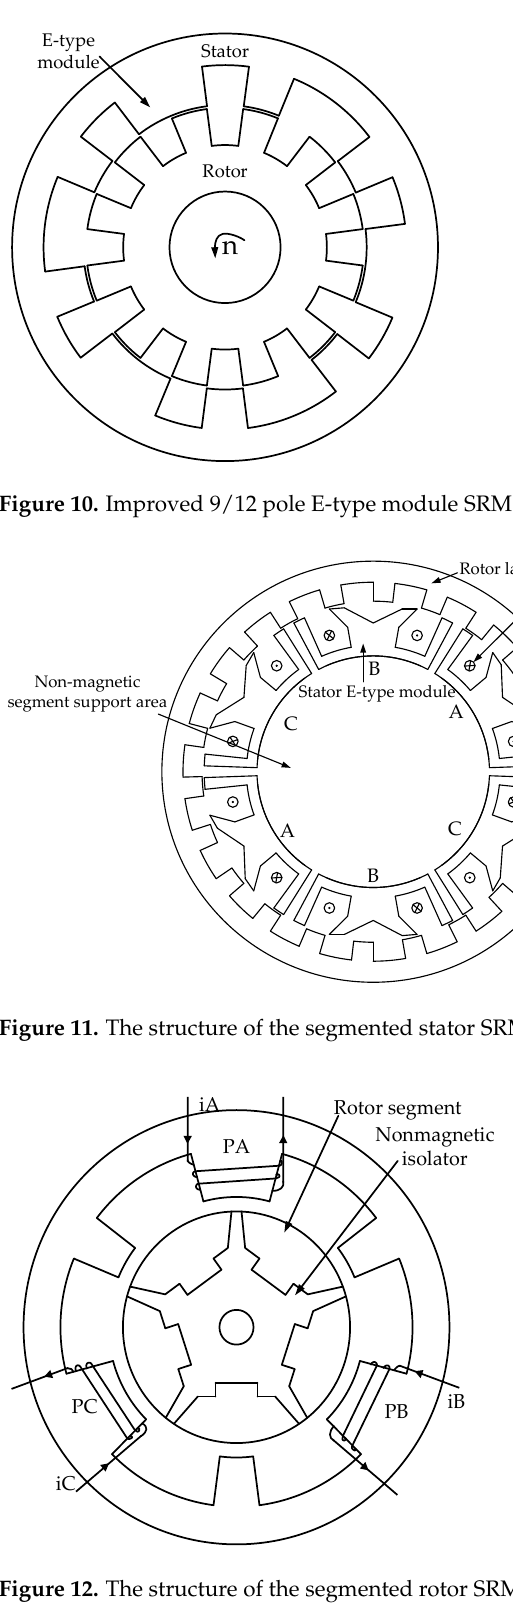
Shaft Figure 13. Comprehensive segmented yokeless rotor SRM [35].